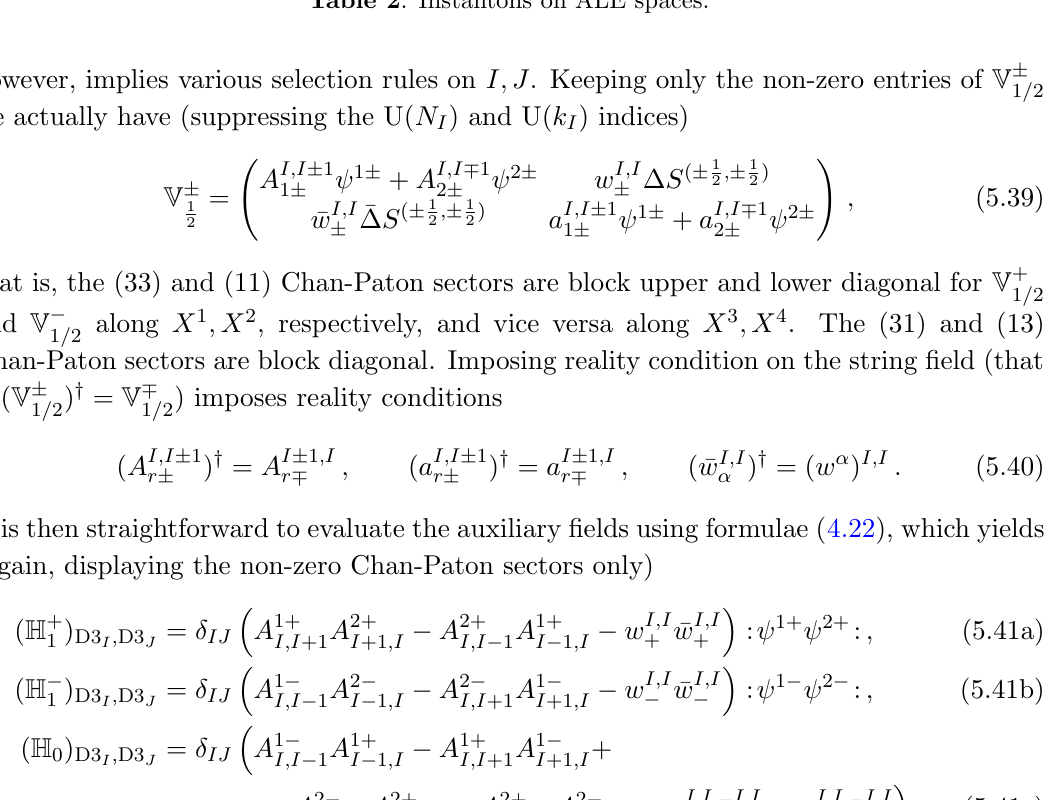
Table 2 . Instantons on ALE